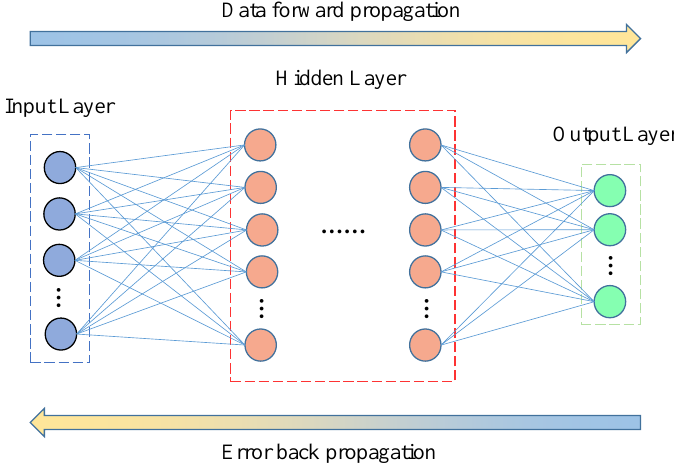
Figure 4. Schematic diagram of ANN